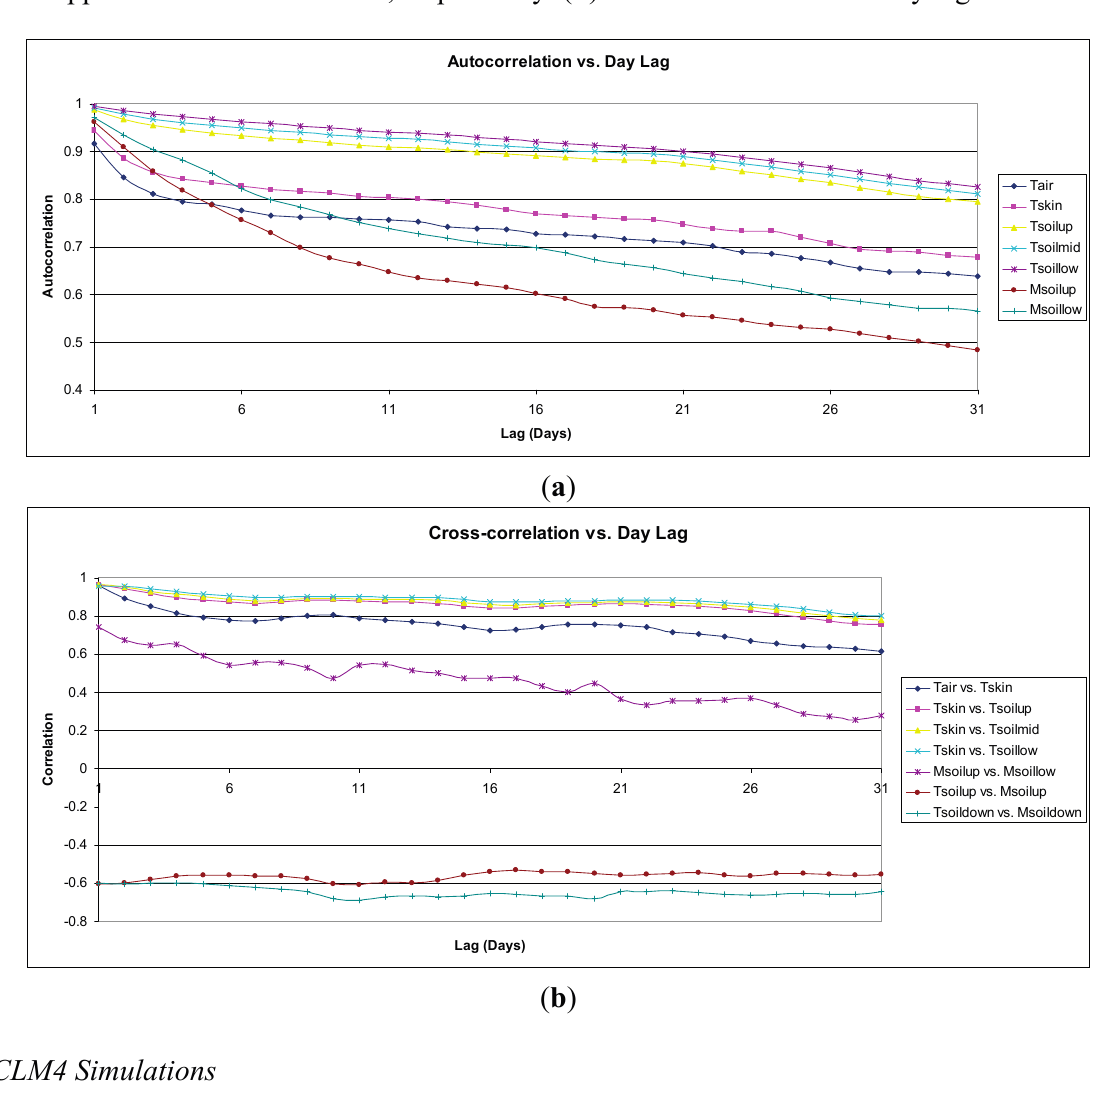
is skin temperature. T is upper soil temperature. T skin soilup soilmid is lower layer soil temperature. M and M soillow soilup soillow